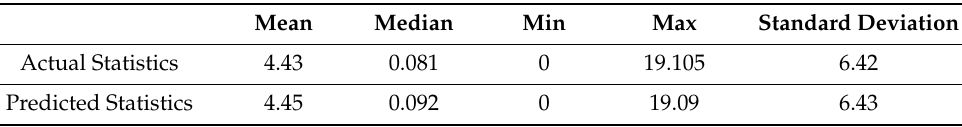
Table 4. Statistical comparison between the actual values of the dc/dt with the predicted values for the pilot dataset with all the features included.